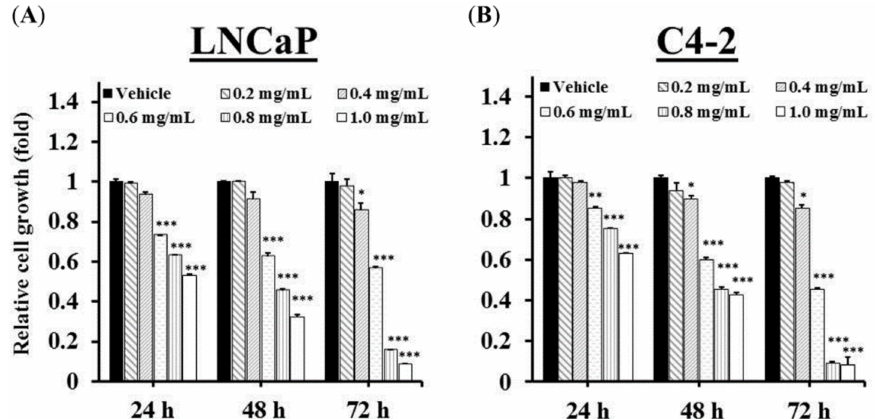
Figure 3. GTEE suppresses the cell growth of PCa cells. ( A ) LNCaP and ( B ) C4-2 cells were treated with vehicle (0.3% ethanol) or GTEE (0.2, 0.4, 0.6, 0.8 or 1.0 mg/mL) for 24, 48 and 72 h. Cell growth was determined by MTS assay. The relative cell growth (fold) was assigned as 1.0 in vehicle-treated cells at each time point. Data were shown as the mean ± SD of three independent experiments. * p < 0.05, ** p < 0.01, *** p < 0.001.